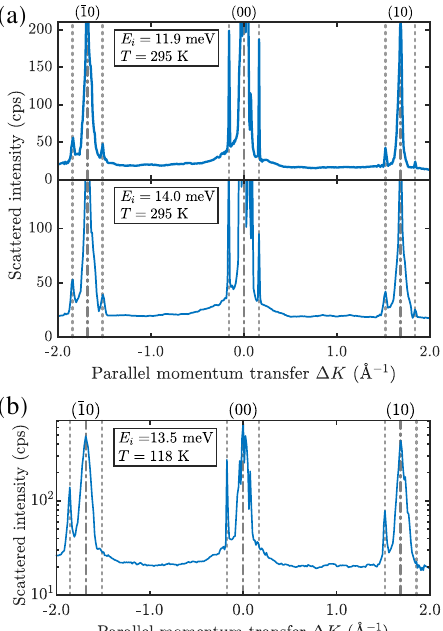
Figure A1. ( a ) Additional full diffraction scans taken at room temperature and with varying incident beam energy E i further illustrate the spin-allowed CDW periodicity of Bi 2 Te 2 Se(111) along Γ M. The corresponding satellite peaks (grey dashed vertical lines) appear next to the specular and first-order diffraction peaks (grey dash-dotted vertical lines). ( b ) An additional full diffraction scan (logarithmic scale), with the sample cooled down, illustrates that the asymmetry between + g CDW and − g CDW , as described in the main text, is also evident for the satellite peaks next to the first-order diffraction